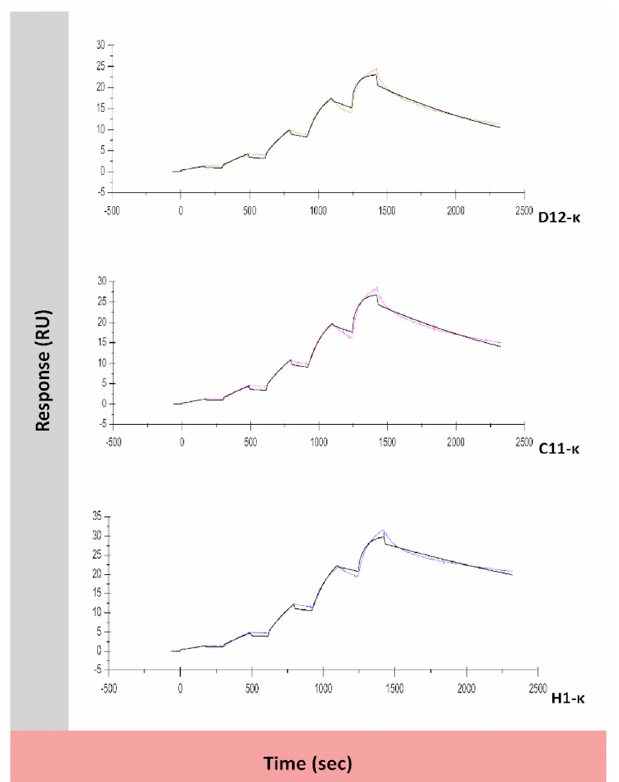
Figure 5. Surface plasmon resonance (SPR) sensorgrams for the kinetic interaction between anti-canine CD117 IgG1s (analyte) and the canine CD117-hFc (ligand). The CM5 sensorchip was prepared with low-level immobilization, and single-cycle kinetics were performed at a high flow rate of 100 µ L/min, allowing a 1:1 binding model to be fit to the data. A 1:1 binding model (black line) was fit to the